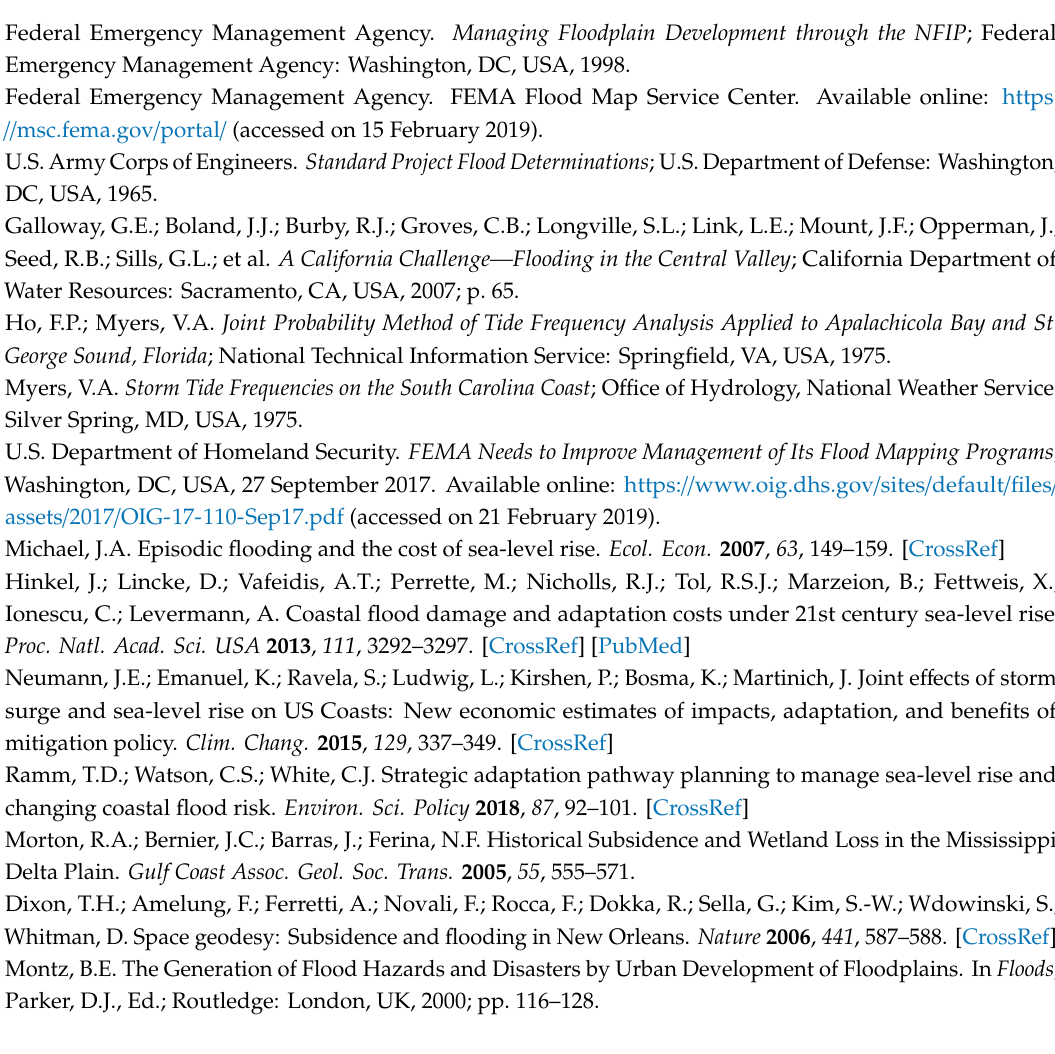
Figure S1: Total land area of floodplain extent by year and return period. The dark line indicates median estimates, while the shaded area indicates the range between 10th and 90th percentile estimates, Figure S2: Populated land area of floodplain extent by year and return period. The dark line indicates median estimates, while the shaded area indicates the range between 10th and 90th percentile estimates, Figure S3: Di ff erence in